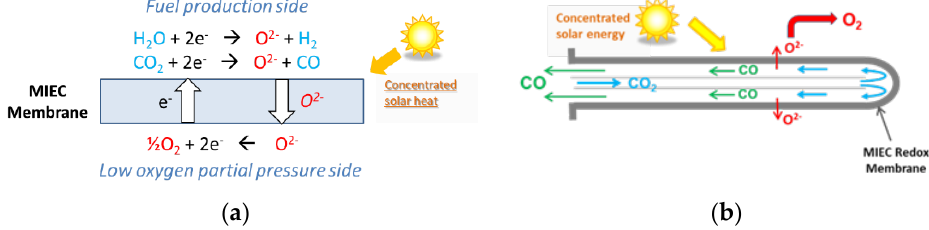
Figure 8. Membrane solar reactor: ( a ) Operating principles of the isothermal MIEC membrane with mixed oxygen-electron transfer under a gradient of p O2 between both membrane sides; ( b ) Gas flow on the sweep and feed sides, and ion transport through the tubular dense membrane (closed one-end) for continuous separation of oxygen and CO.